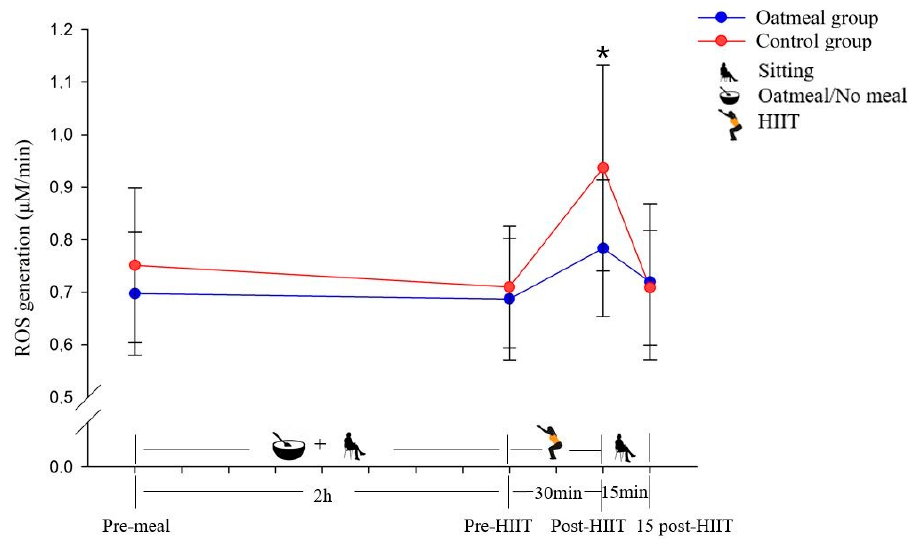
Figure 2. Changes of the reactive oxygen species (ROS) generation in μ M/min (mean ± SD) from pre-meal to 15 post-HIIT in the two groups (* p < 0.05; a significant difference between the oatmeal group and control group was detected by an independent t -test).